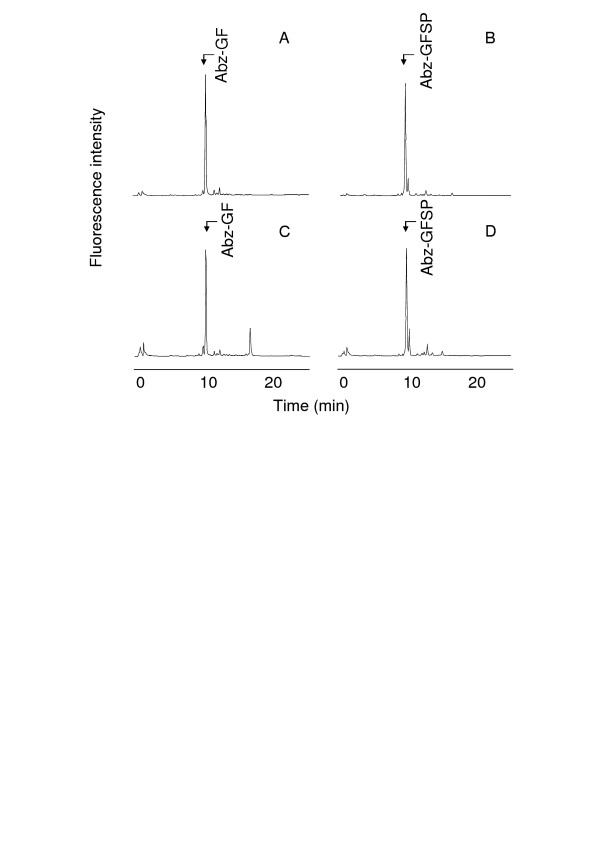
HPLC analysis of FRET peptides degradation by the B16F10-Nex2 supernatant. Abz-GFSPFR-EDDnp (A, C) or Abz-GFSPFRQ-EDDnp (B, D) were incubated with recombinant oligopeptidase TOP (A, B), or B16F10-Nex2 supernatant (C, D) in 50 mM Tris-HCl pH 7.4 at 37°C. Reaction products were separated by HPLC and were identified by mass spectrometry. Chromatograms developed by fluorescence detection at λem. = 420 nm and λex. = 320 nm.